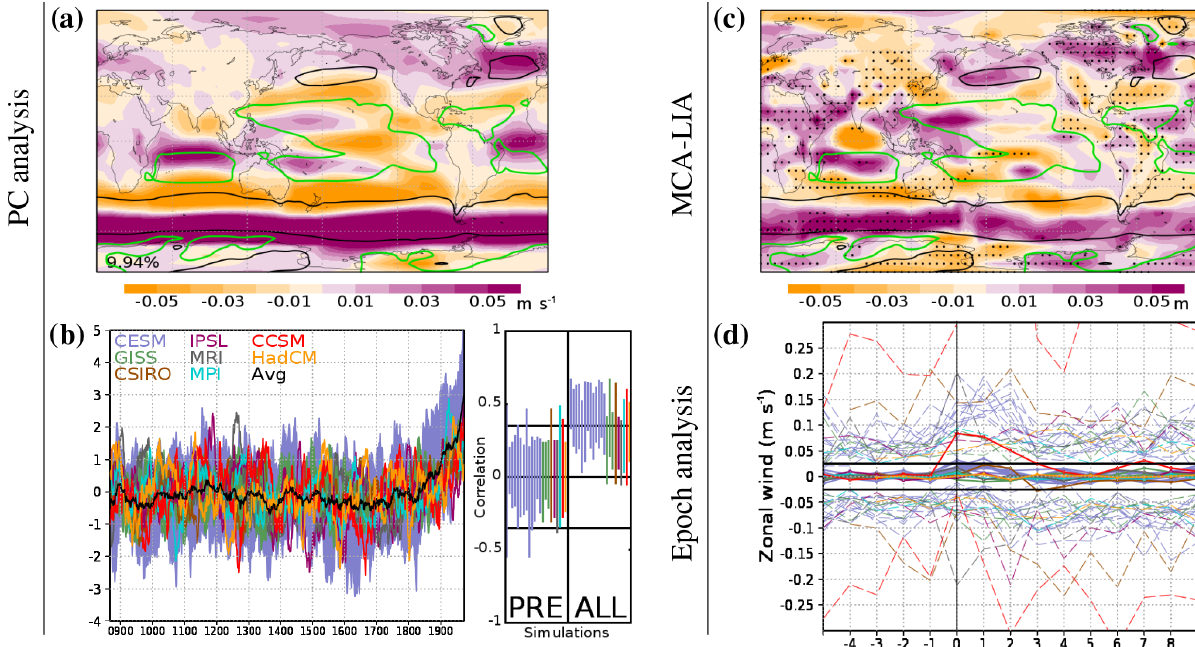
Figure 7. Analysis of zonal wind for the ensemble of simulations included in Table 1. (a) First EOF and (b) first PC time series for each simulation, as well as the average PC of all the simulations (black line). The percentage of explained variance is shown within the EOF map. The range of correlations between the PC of each simulation and those of other simulations is also included on the right of the plotted PCs both for the whole period (ALL) and for the preindustrial era (PRE). For these correlations, the significance level ( p < 0 . 05) accounting for autocorrelation is shown with a black line. (c) Map of zonal wind differences between MCA and LIA. Dots indicate locations where the differences are significant ( p < 0 . 05). Contours with climatological wind of − 6ms − 1 (east winds; green) and 6ms − 1 (west winds; black) are included in the EOF and MCA–LIA maps. (d) Composite average (solid lines) and maximum and minimum (dashed lines) global zonal wind anomalies in the 5 years before and 10 years after the 12 main volcanic eruptions of the LM. The vertical line indicates the year of the volcanic event. The horizontal black lines show the significance level of the average ( p < 0 . 10) based on the distribution of averages of 12 years generated with 2200 sets randomly taken from the whole period excluding the years of the 12 main volcanic eruptions and the 10 years after